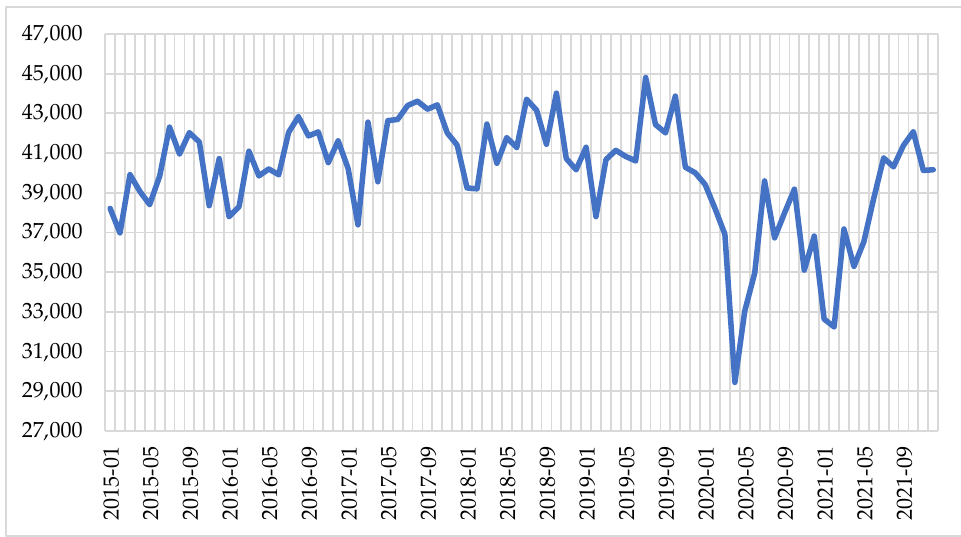
Figure 11. Shaping the volume of deliveries of oil products to EU countries (in thousand tonnes). Source: own elaboration.